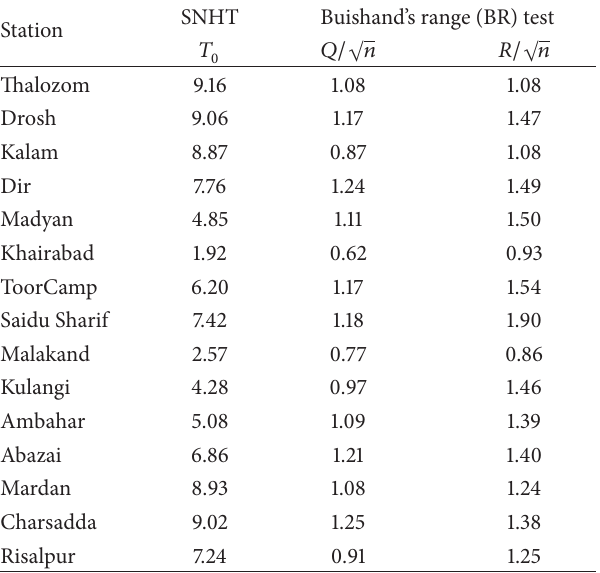
Table 1: Results of homogeneity tests for mean annual precipitation time series at study